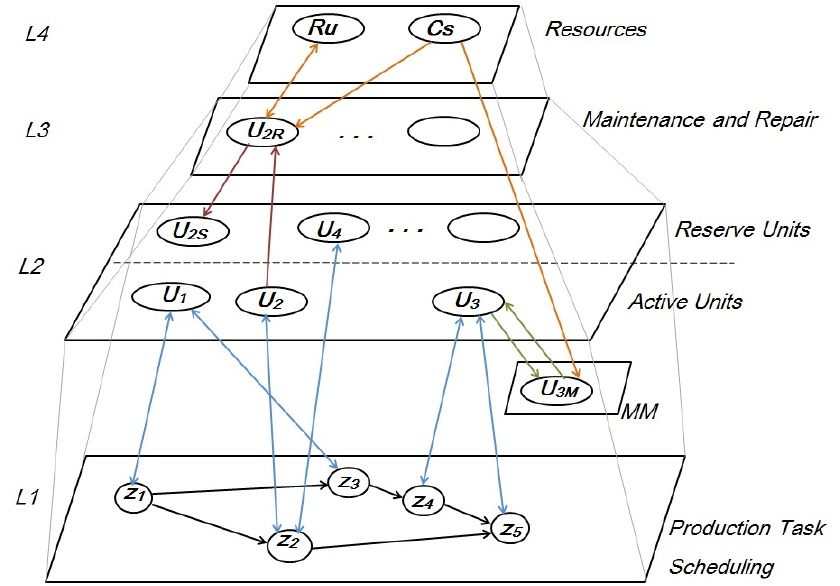
Figure 1. The scheme of interaction of technological objects and tasks of the technological process.